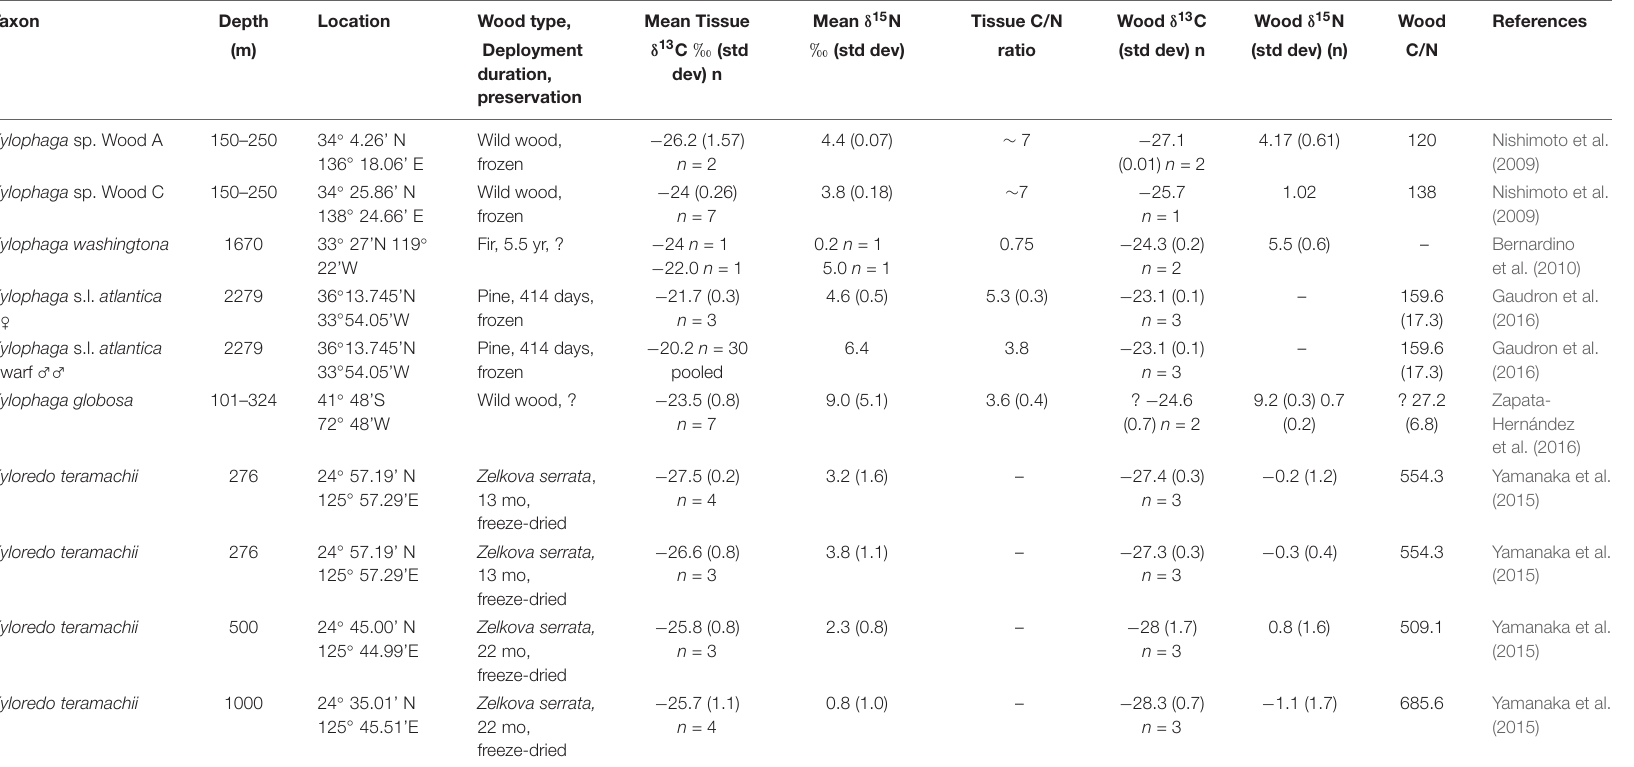
TABLE 3 | Literature data for δ 13 C and δ 15 N of